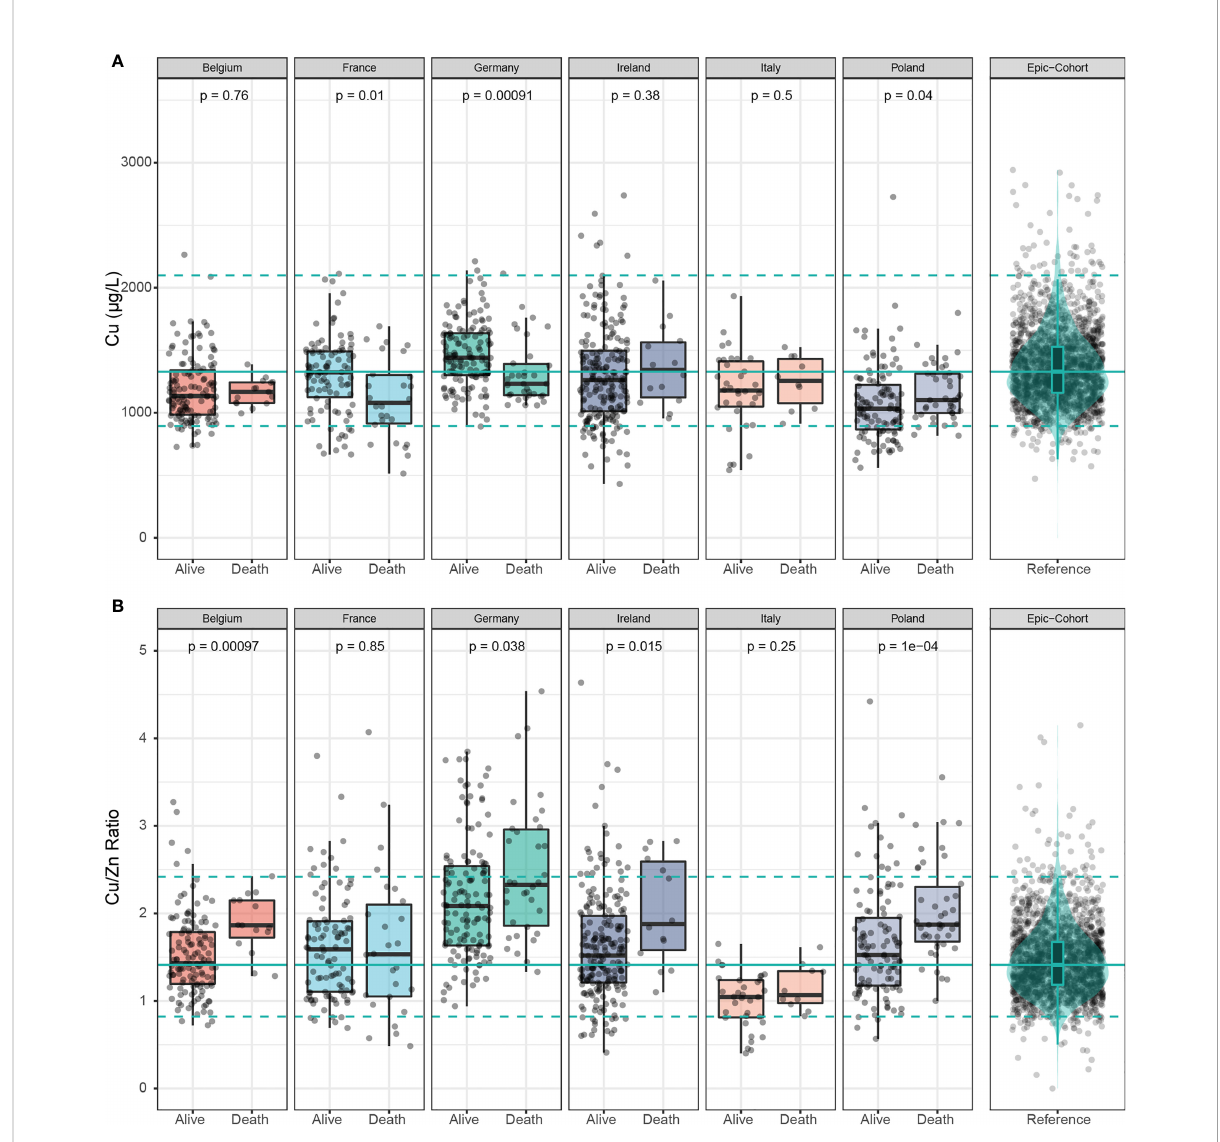
FIGURE 4 Cu and Cu/Zn status in samples of deceased and alive patients. (A) Serum Cu concentrations showed inconsistent differences between samples of deceased and alive patients across all countries. (B) The serum Cu/Zn ratios was relatively higher in non-survivors than in survivors in all the countries with France as the exception. The green line denotes the median value as determined in EPIC, and broken lines indicate the 2.5 th and 97.5 th centiles. Results from Wilcoxon-Rank-sum testing are indicated as